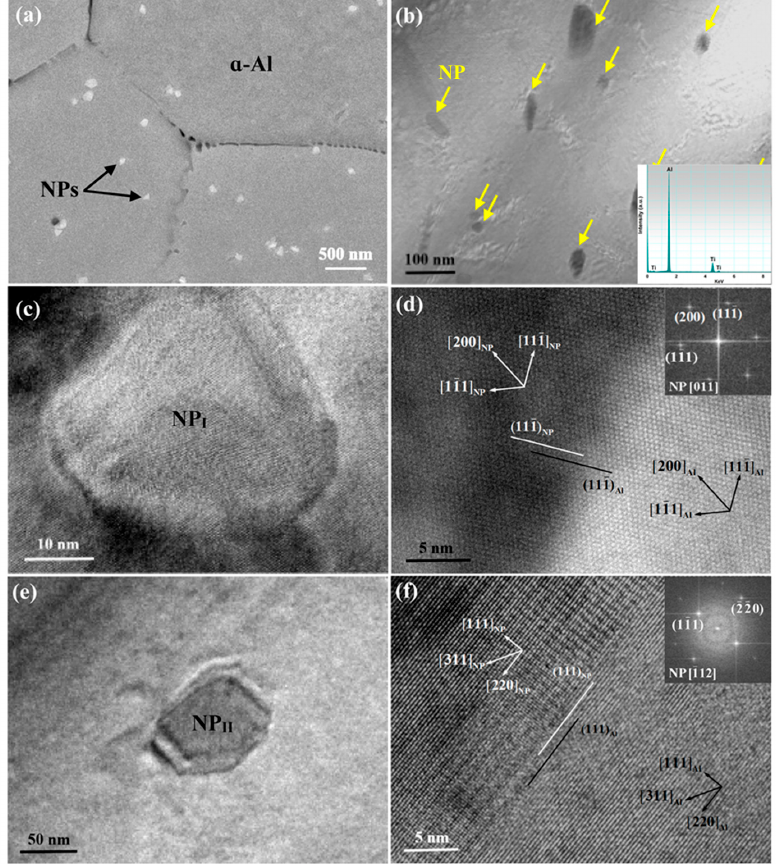
Figure 5. ( a ) SEM micrograph of CP Al with 2.0 vol.% NP addition solidified at the cooling rate of 70 K/s; ( b ) TEM bright field image showing the NP distribution within the interior of grain; ( c , e )